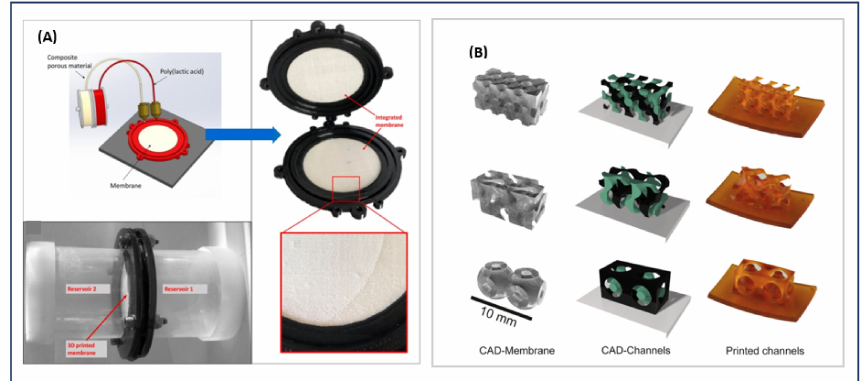
Figure 6. Structures of complex shapes of 3D-printed membranes. ( A ) Design of an integrated membrane device [27]. Reproduced with permission from Kalsoom, U.; Hasan, C.K.; Tedone, L.; Desire, C.; Li, F.; Breadmore, M.C.; Nesterenko, P.N.; Paull, B., Low-Cost Passive Sampling Device with Integrated Porous Membrane Produced Using Multimaterial 3D Printing; Anal. Chem., Ameri- can Chemical Society, 2018. ( B ) Sheetlike triply periodic minimal-surface architecture (TPMS)-like 3D membrane [48]. Reproduced with permission from Femmer, T.; Kuehne, A.J.C.; Wessling, M. Print Your Own Membrane: Direct Rapid Prototyping of Polydimethylsiloxane, Lab Chip; published by Royal Society of Chemistry,